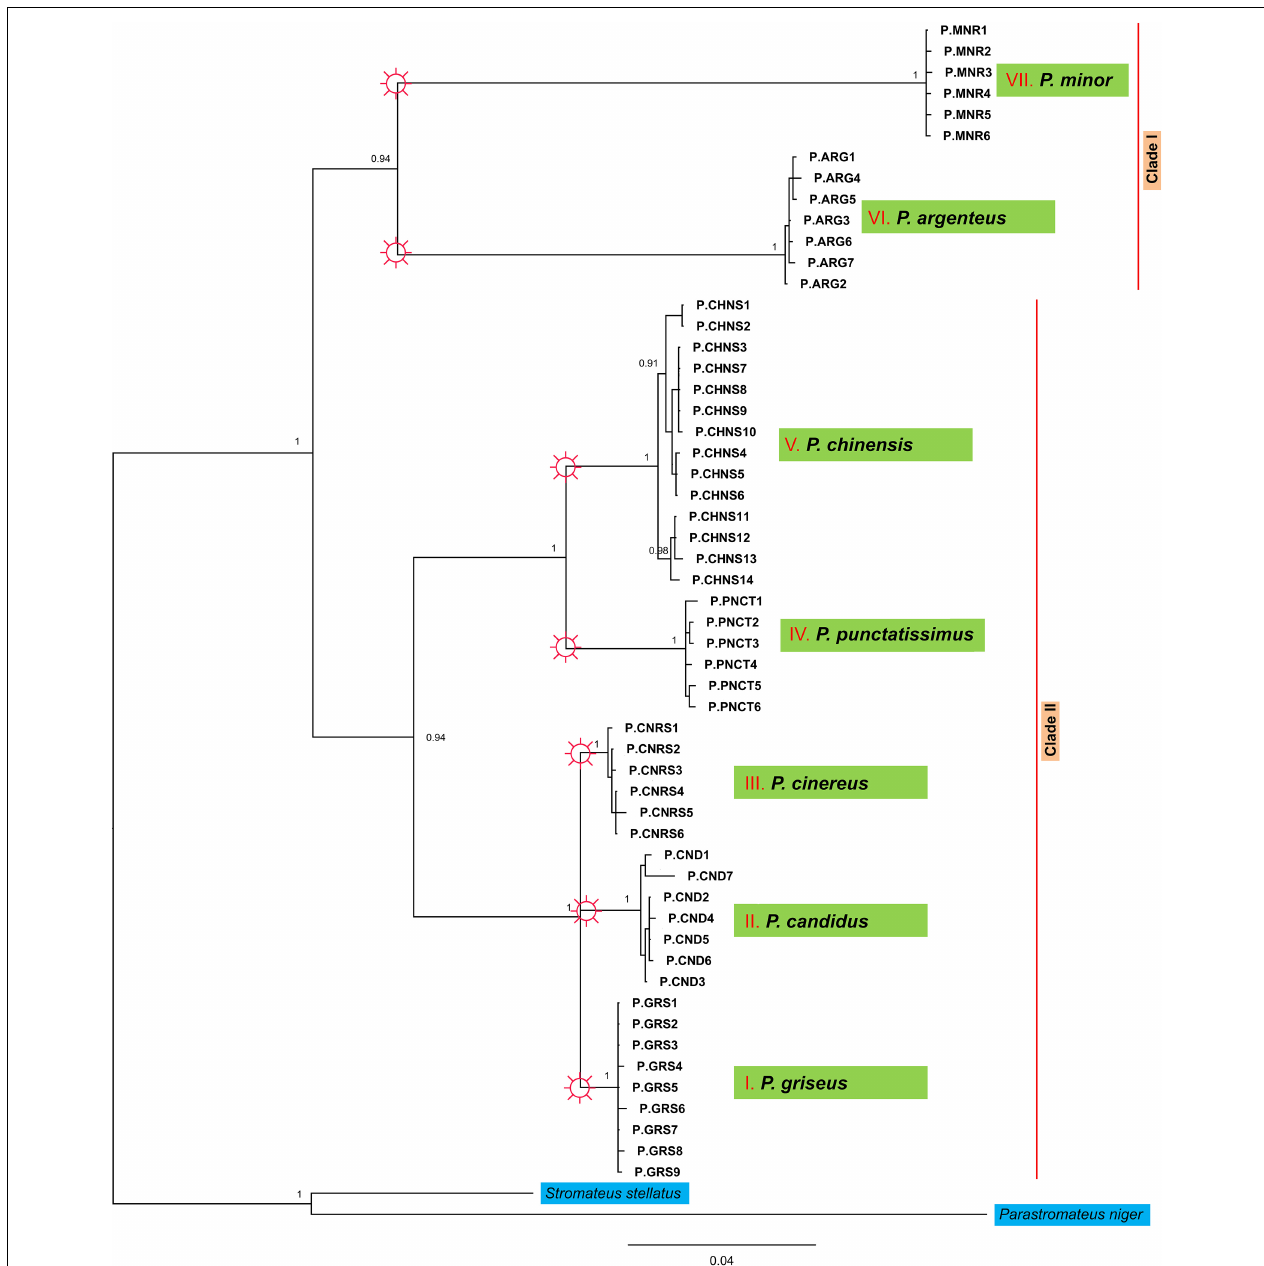
FIGURE 2 | Bayesian inference (BI) tree of genus Pampus based on concatenated dataset of 16S, COI, and Cyt b partial sequences ( Supplementary Table 2 ). Support values on branches indicate Bayesian posterior probability (BPP) values. Internal branch values are not represented in the Figure. Species identified from Generalized Mixed Yule Coalescent (GMYC) model is shown with the symbol on the